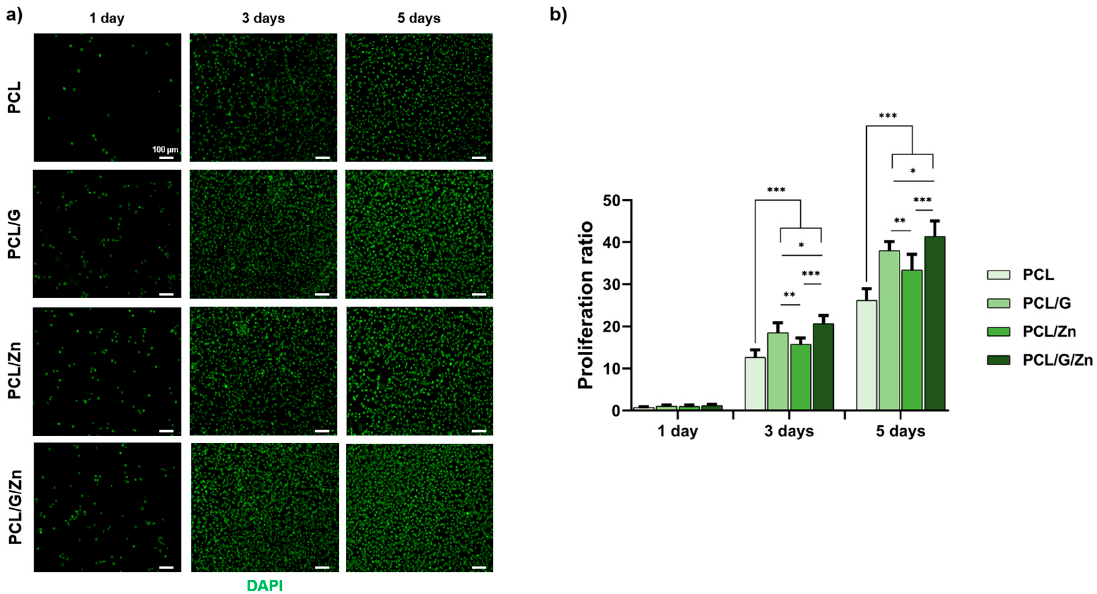
Figure 4. Myoblast proliferation seeding in growth medium. ( a ) Representative cell density (DAPI nuclei staining) at 1, 3 and 5 days after culture; ( b ) Proliferation ratio obtained as the ratio between total cell density and initial cell density. (*) p < 0.05, (**) p < 0.01, and (***) p < 0.001. The combination of a conductive nanocomposite surface and exogeneous Zn 2+